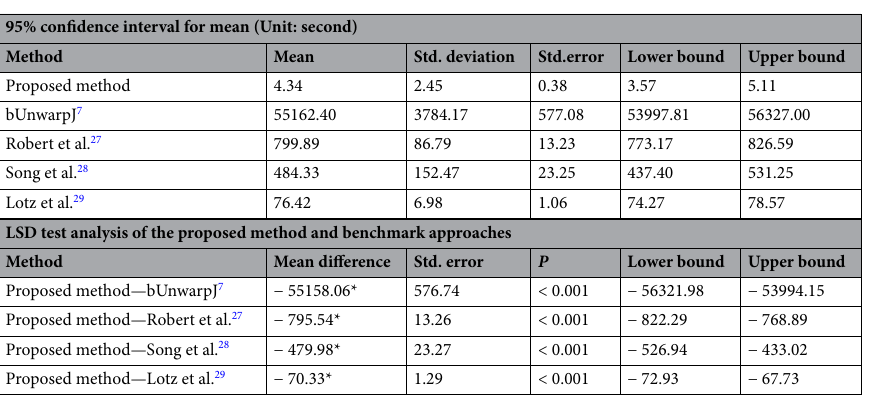
Table 4. Run time analysis in cross-staining WSI registration. *The proposed method performs significantly faster than the benchmark approaches ( p < 0.001 )